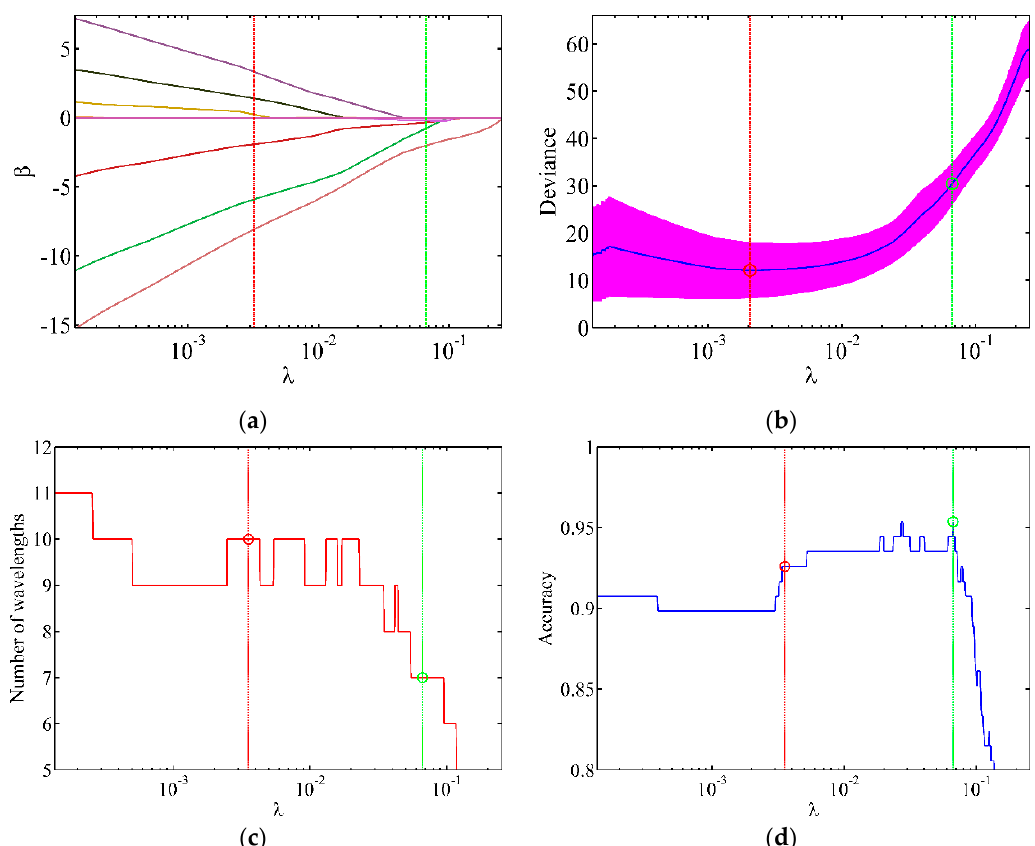
Figure 6. Change in parameters with different λ values. ( a ) Regression coefficient; ( b ) fitting deviation; ( c ) number of feature wavelength bands; ( d ) prediction accuracy.